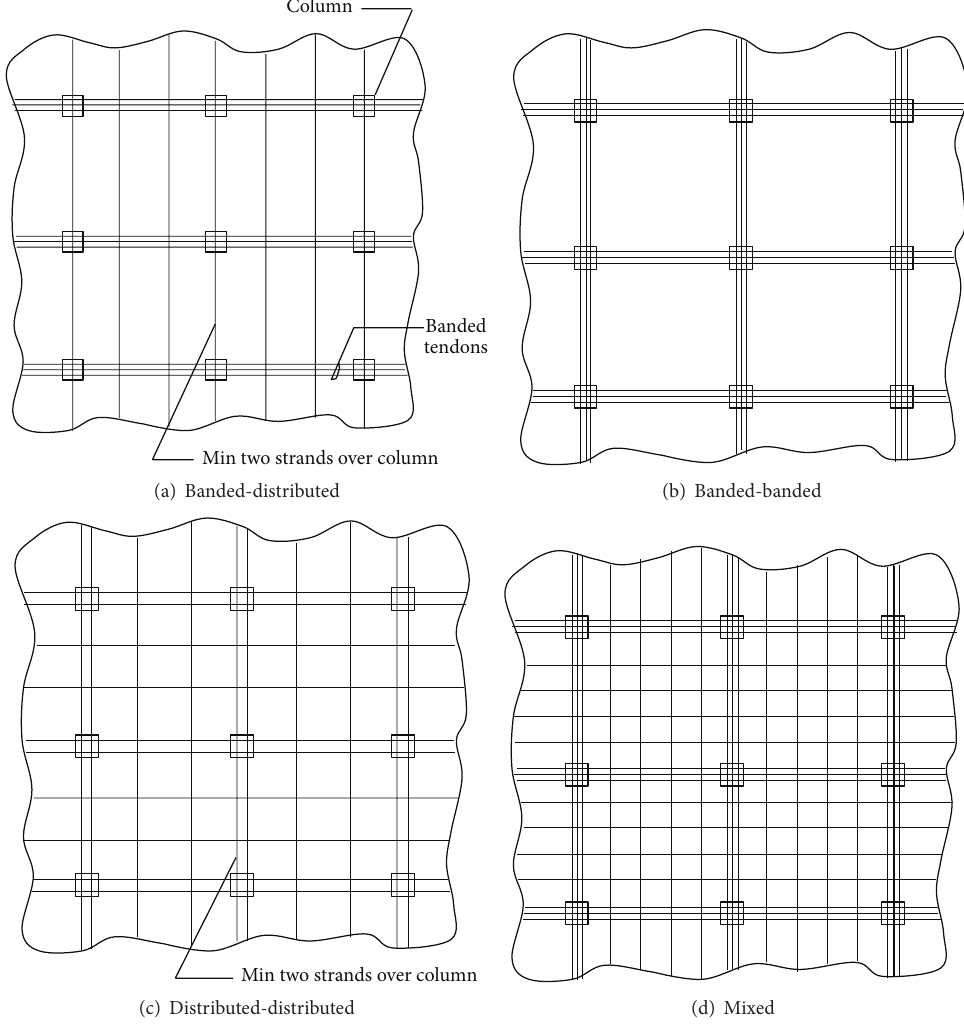
Figure 1: Principal options of tendon layout